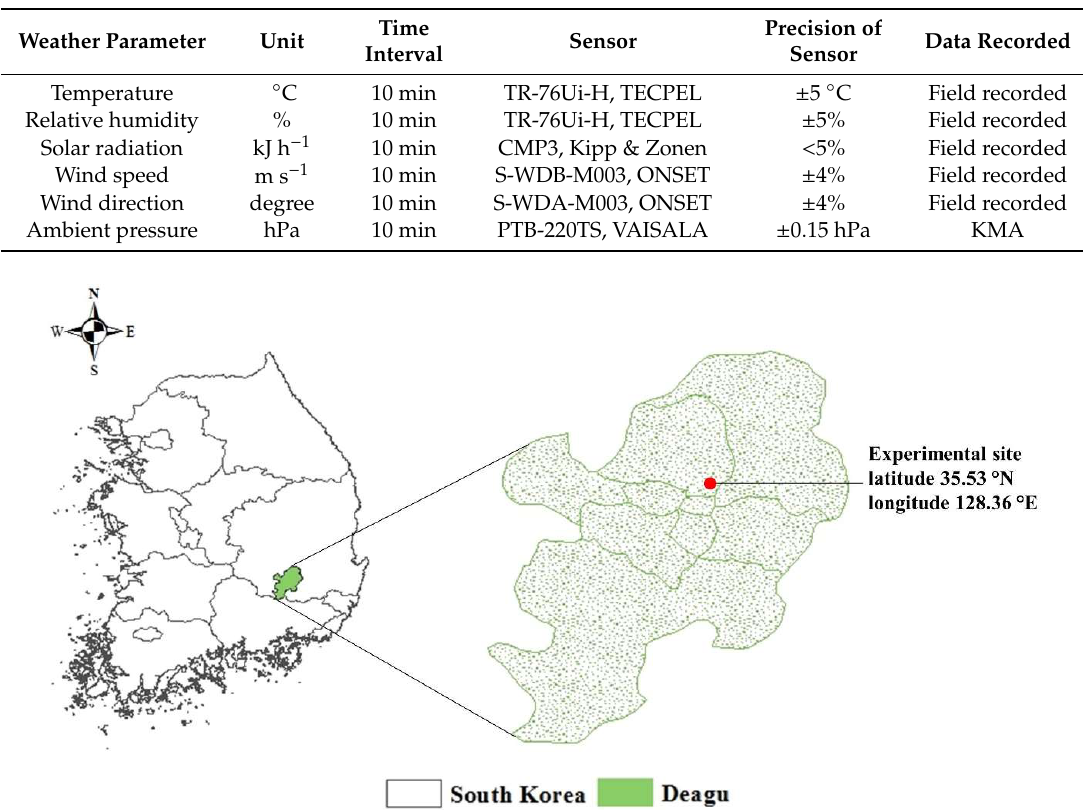
Table 1. Weather data variables used in the simulations.